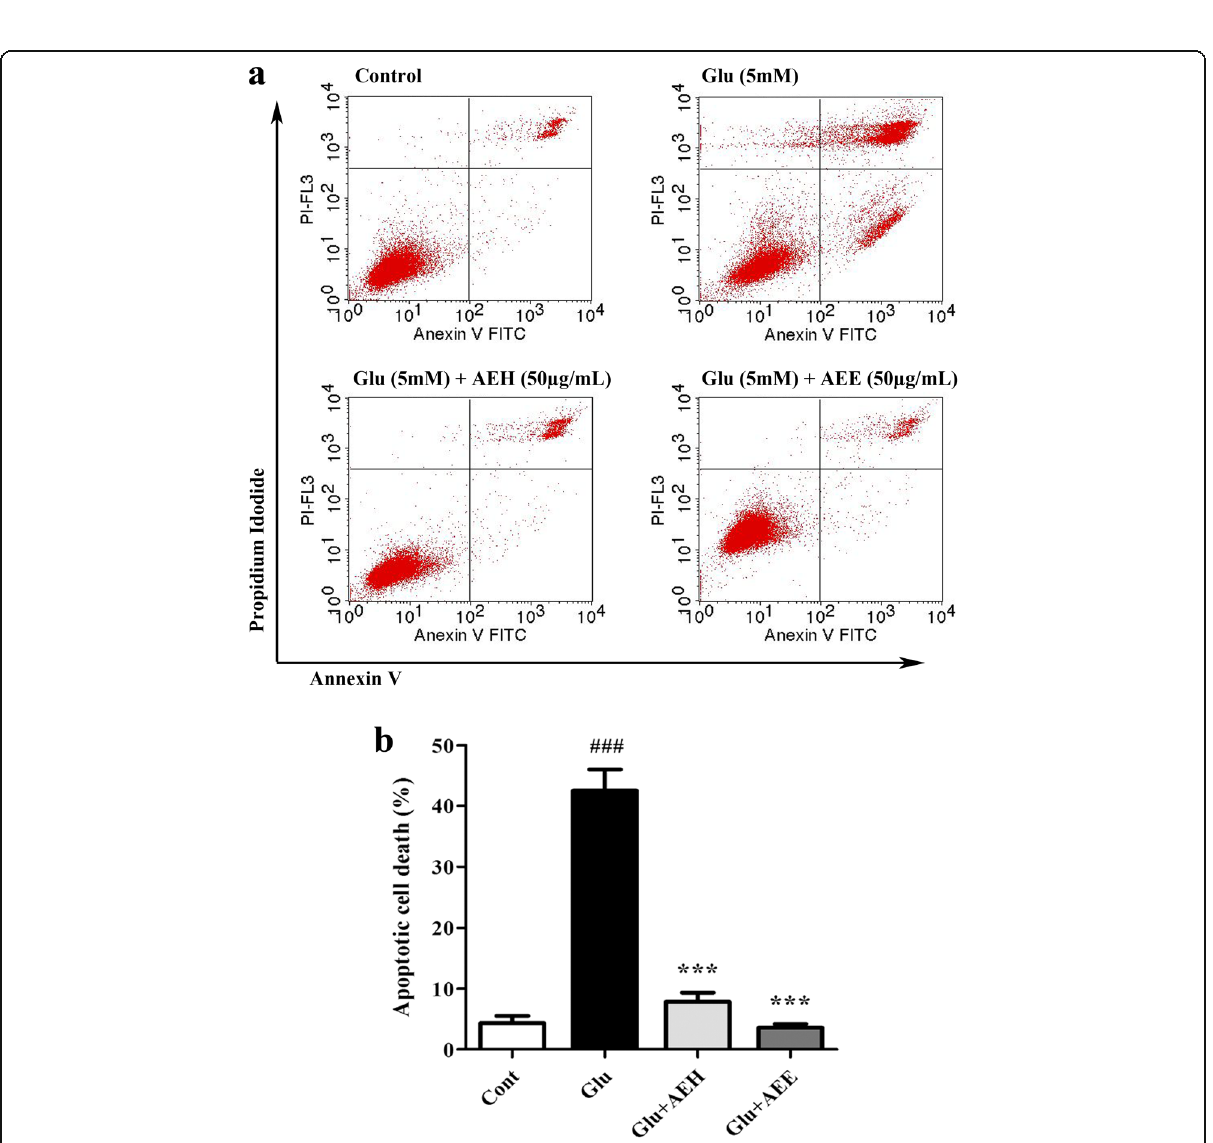
Fig. 3 Protective effect of AE leaf extracts against glutamate-induced apoptotic cell death in HT22 cells. ( a ) Representative flow cytometric scatter plots of annexin V-FITC and PI staining in untreated HT22 cells (control), or cells exposed to 5 mM glutamate alone or glutamate combined with either AEH or AEE at 50 μ g/mL for 18 h. ( b ) The percentages of apoptotic cells in each treatment group calculated as the sum of annexin V-positive/ PI-negative cells (early-stage apoptosis, lower right quadrant) plus annexin V/PI double-positive cells (late-stage apoptosis, upper right quadrant). Data are expressed as the means ± SD, ### P <0.001 vs. control; ***P <0.001 vs. glutamate